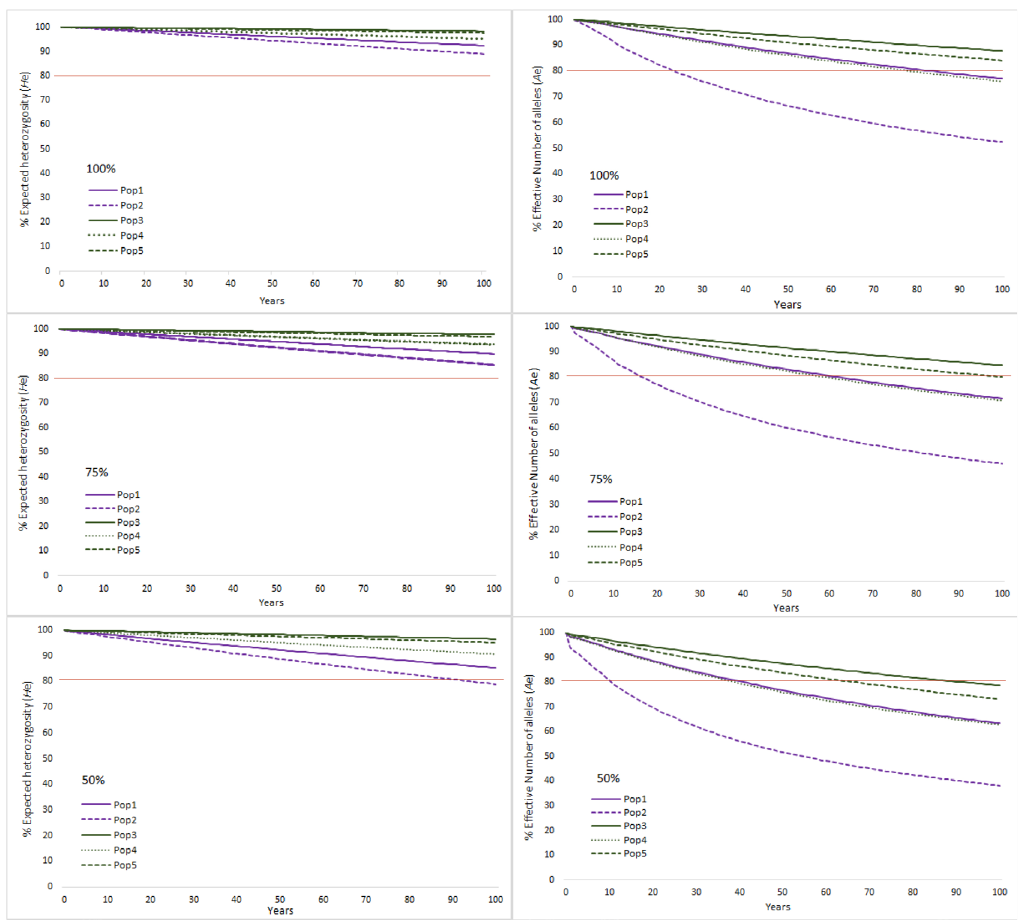
FIGURE 2 | Predicted genetic diversity in Salminus brasiliensis populations with distinct fragmentation levels over the next 100 years. Using BOTTLESIM 2.6, we estimated the retained percentage of effective number of alleles ( A e) and expected heterozygosity ( H e) under 100%, 75% and 50% of retain bottleneck scenarios. In all populations, the current population size is unable to maintain 80% of current genetic diveristy, which it is indicated by a red line.